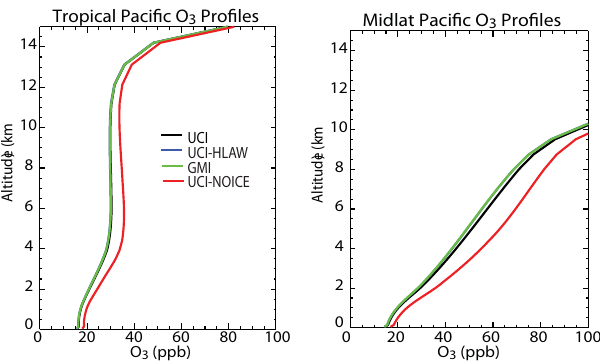
Fig. 5. Profiles of O 3 (ppb) from the UCI (black), UCI-HLAW (blue), GMI (green), and UCI-NOICE (red) simulations, averaged over the Tropical Pacific and Midlatitude Pacific boxes shown in Fig. 3c. In both panels, the black, blue, and green lines overlap in part or all of the